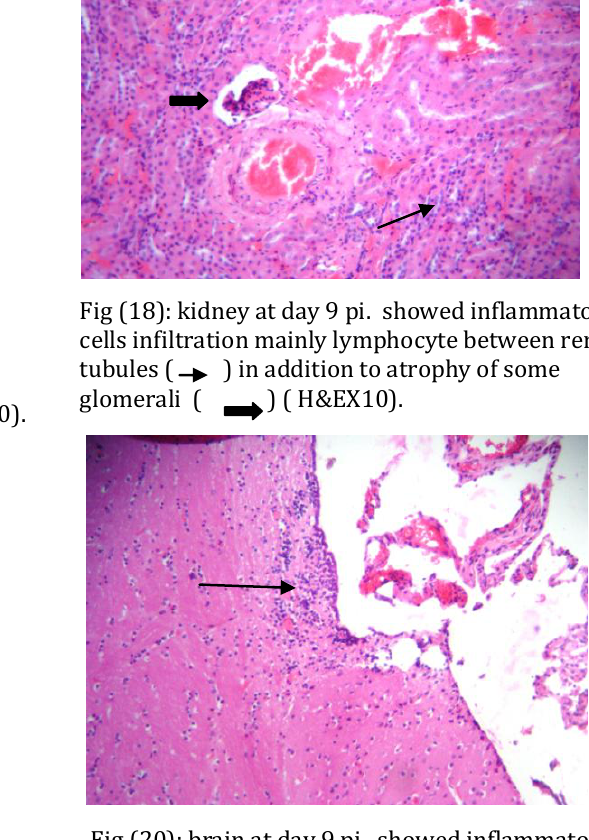
Fig (20): brain at day 9 pi. showed inflammatory cells infiltration ( ) (